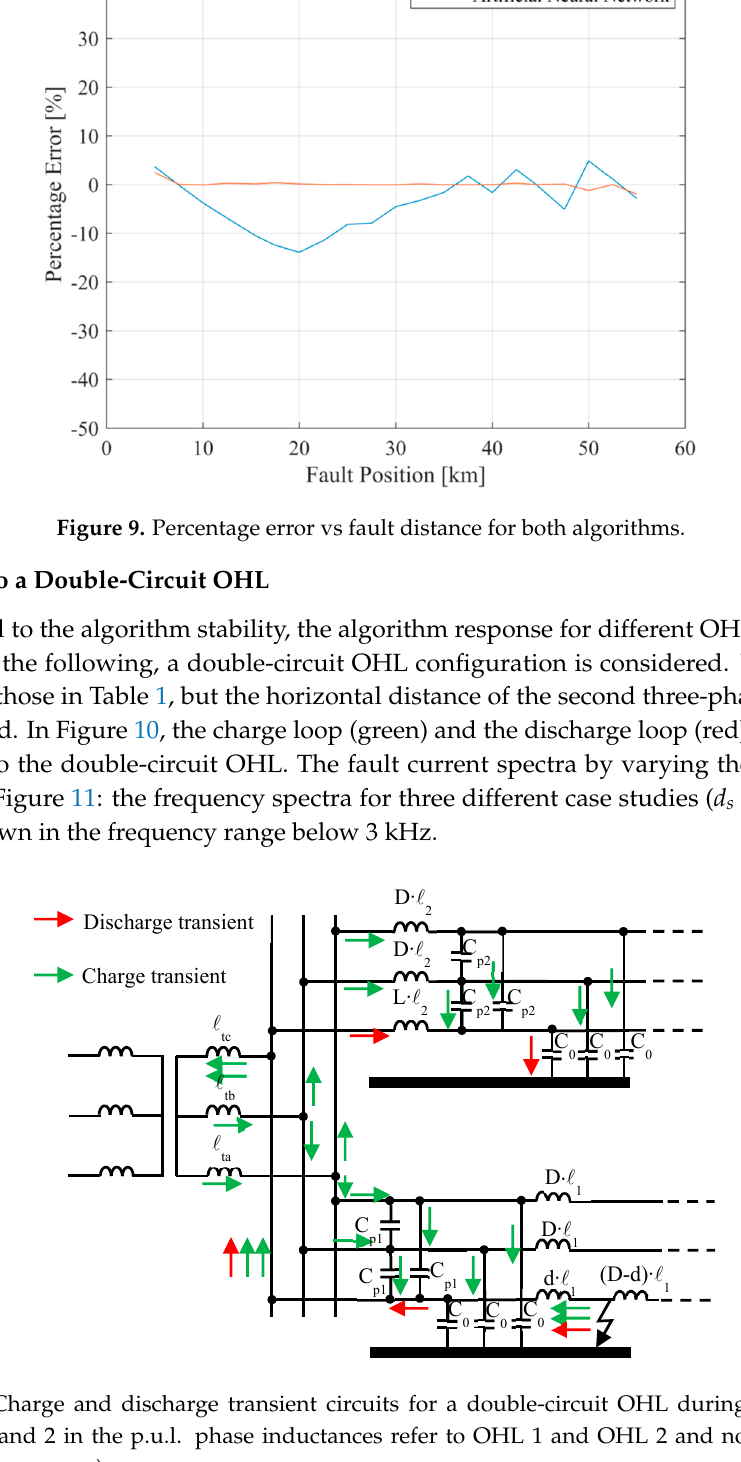
and negative negative sequence).